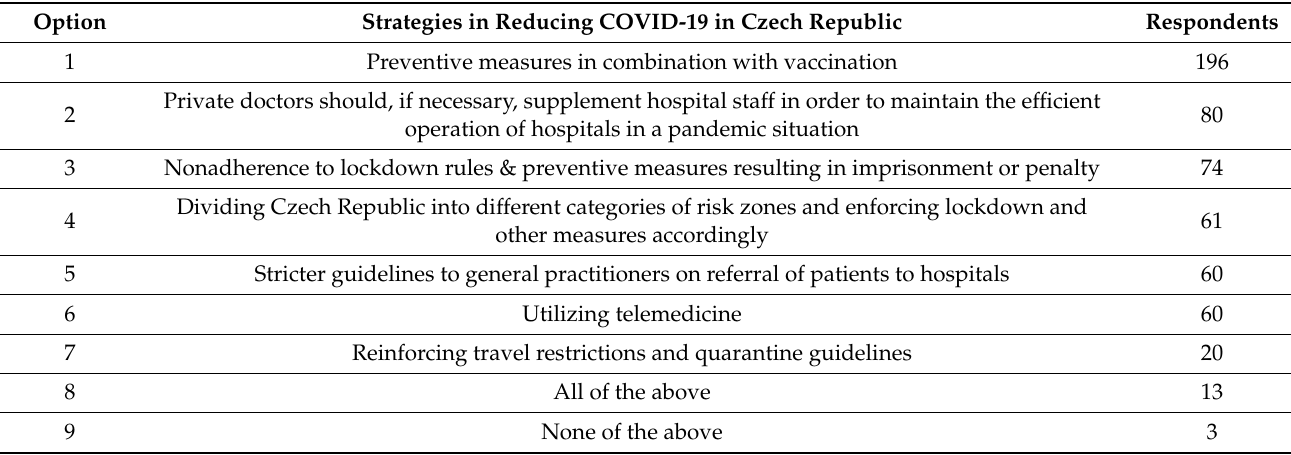
Table 4. Strategies that can help improve the situation with COVID-19 in the Czech